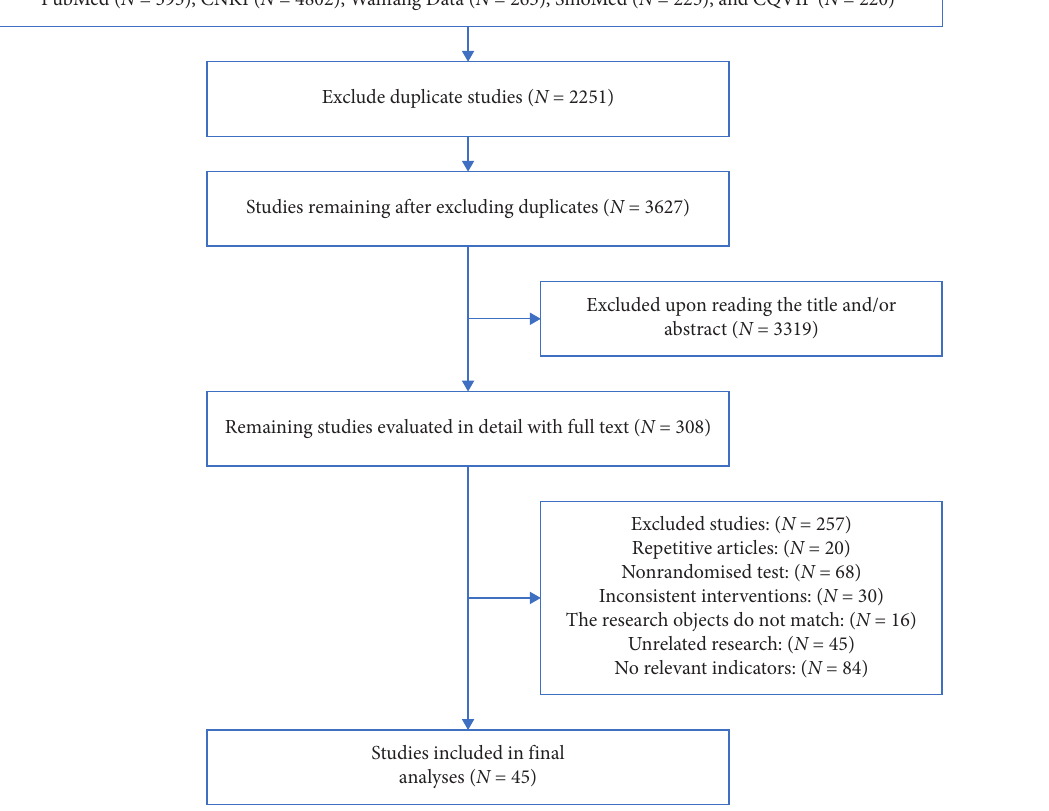
Figure 1: Document screening flow